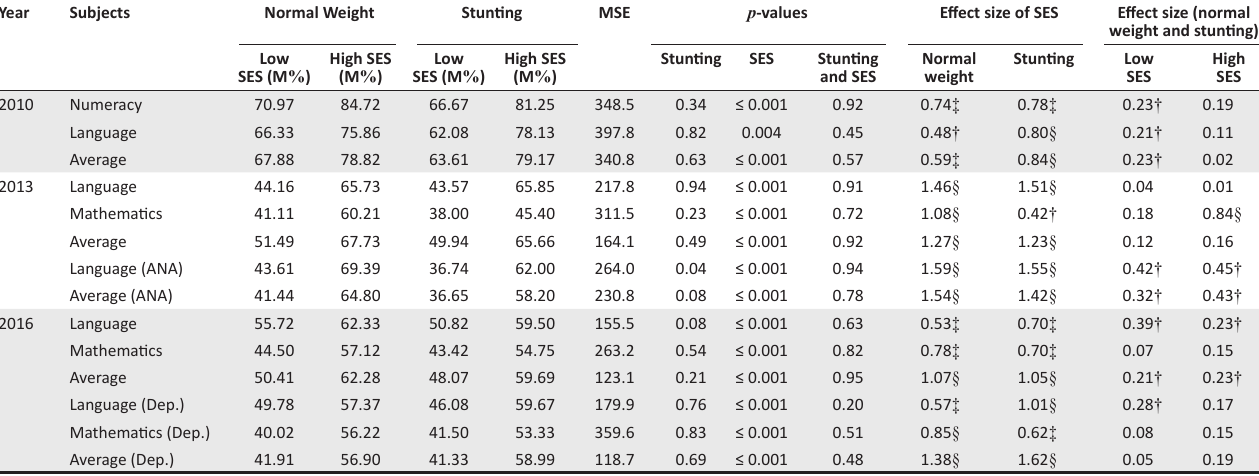
TABLE 4: Analyses of variances between normal weight, stunting and academic subjects per year. Year